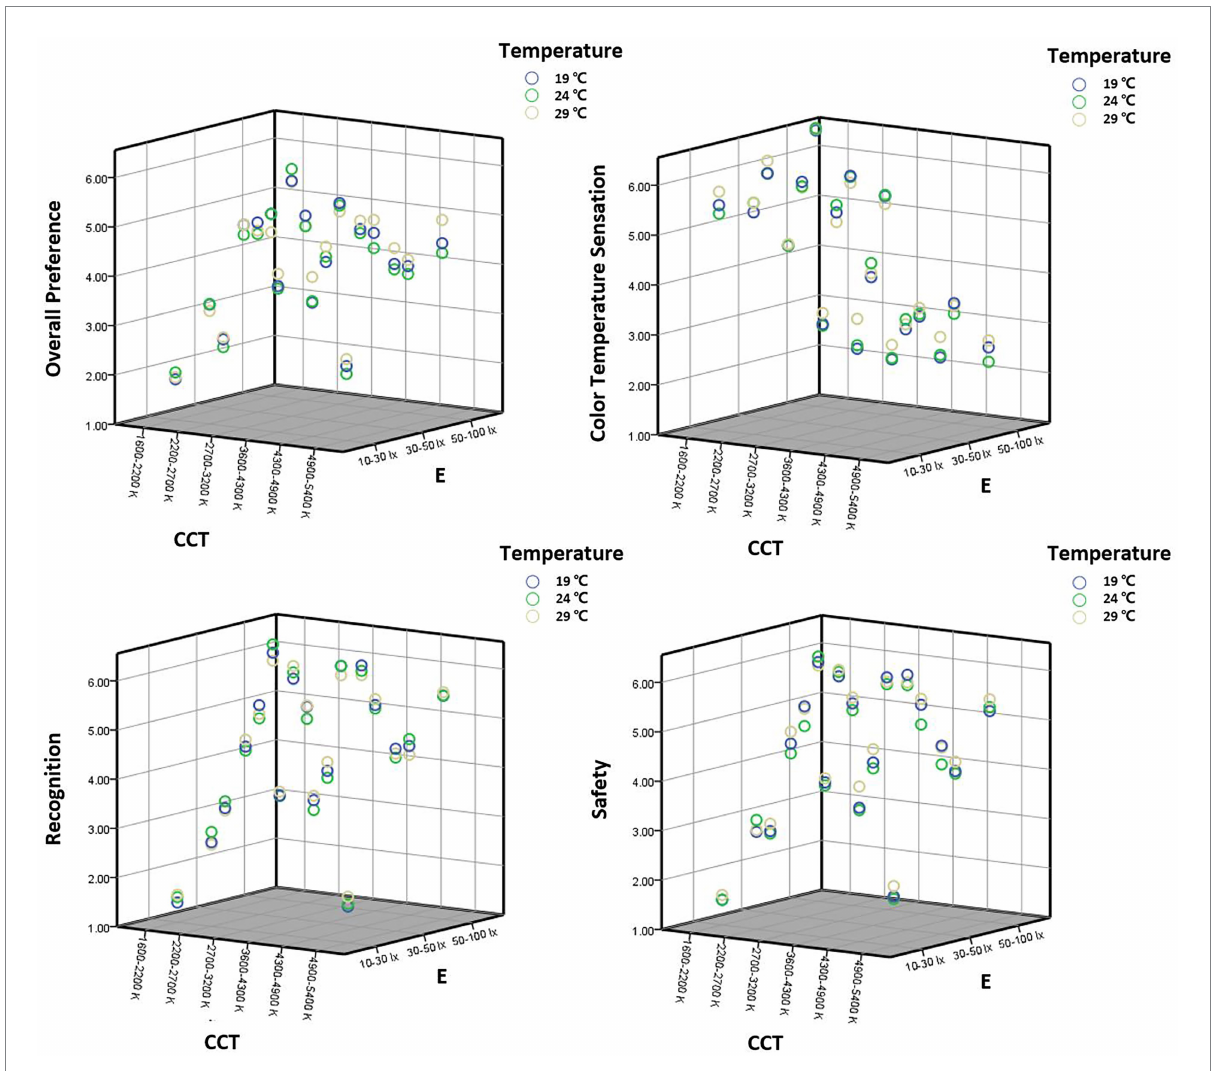
FIGURE 7 Evaluation scatter plots of different street lighting at three experimental